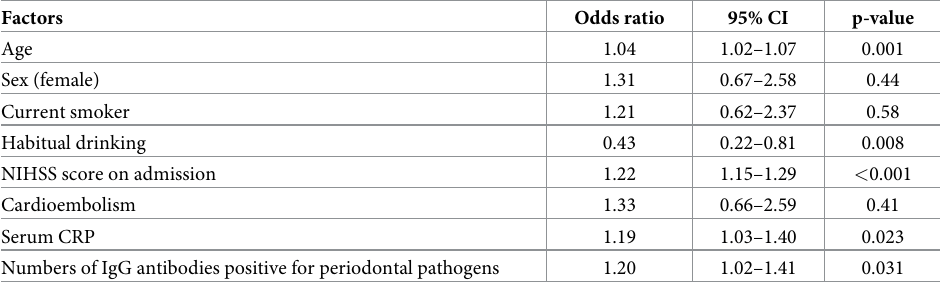
Table 4. Multivariate analyses to determine associations with unfavorable outcome.